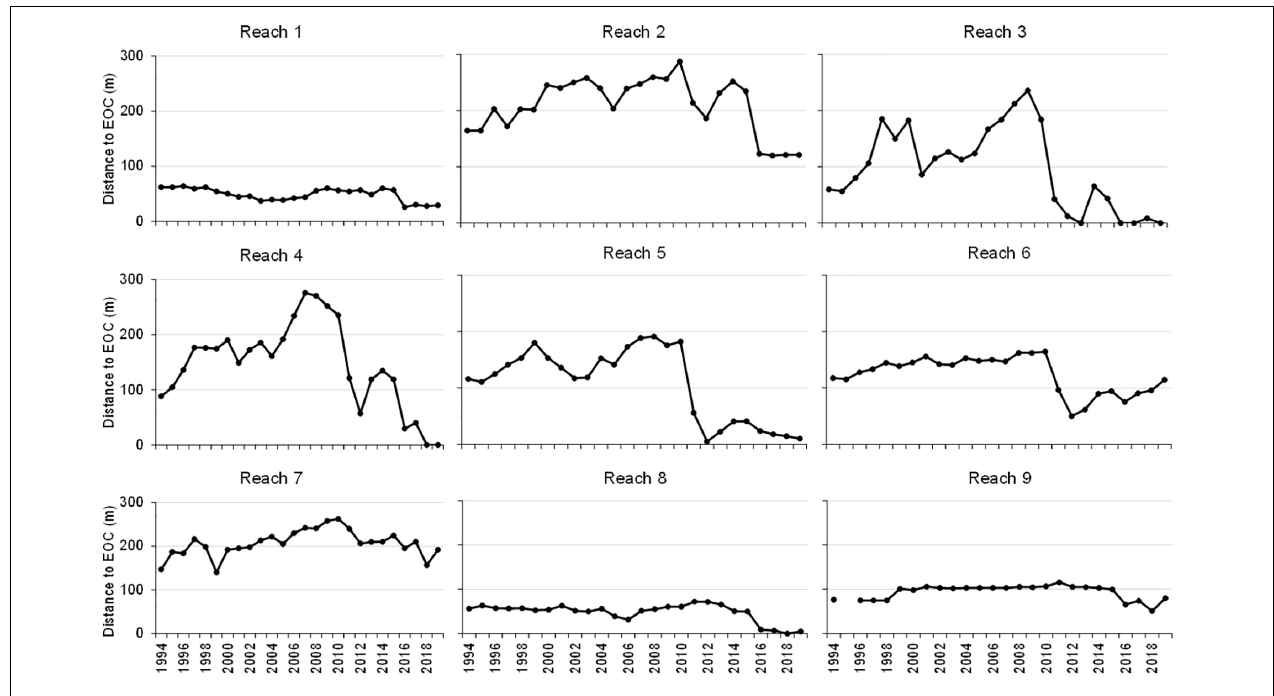
FIGURE 5 | Mean distance to the deep end of the seagrass canopy (EOC).